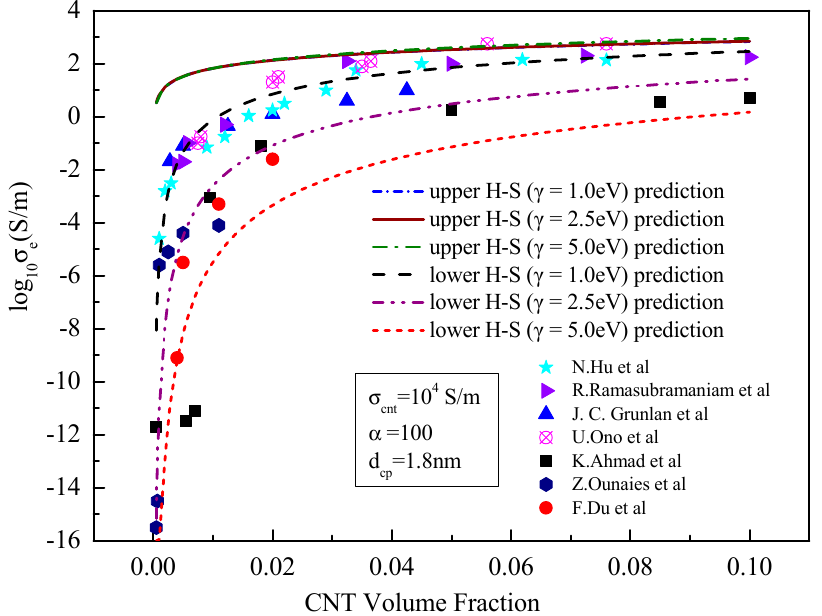
Figure 9. Comparison between the prediction results of the upper- and lower-bound models and existing experimental data [21,23–28] with the variable barrier height.